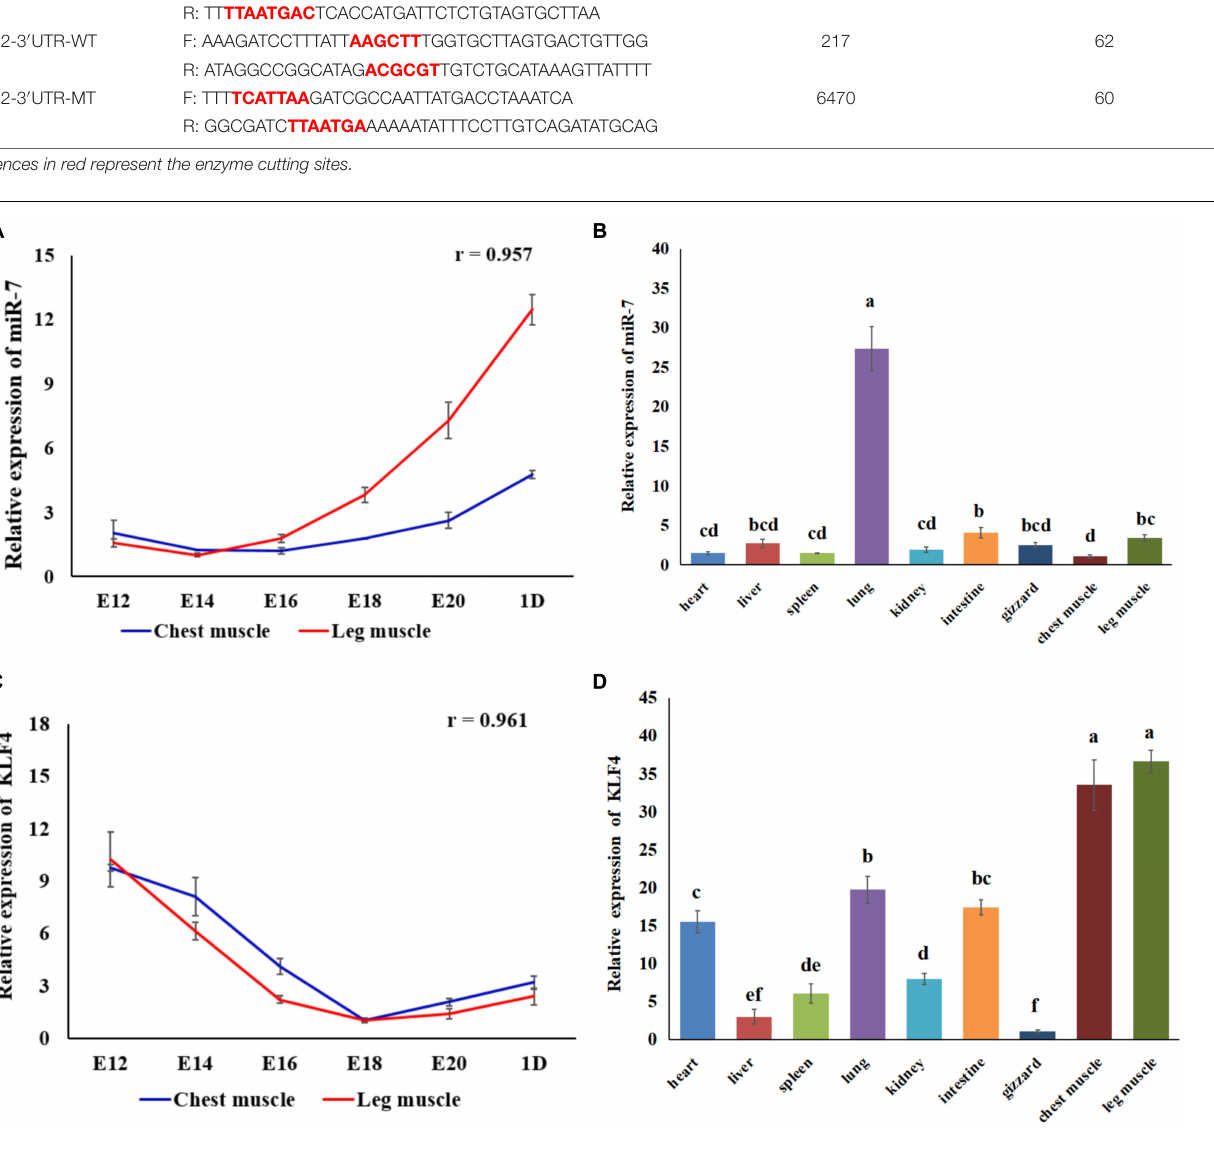
FIGURE 1 | Expression of miR-7 and KLF4 gene in the tissues of Jinghai Yellow chickens. (A) Expression pattern of miR-7 in chest and leg muscles. (B) Expression profile of miR-7 in the tissues of 1-day-old chickens. (C) Expression pattern of the KLF4 gene in chest and leg muscles. (D) Expression profile of the KLF4 gene in the tissues of 1-day old chickens. E12, E14, E16, E18, E20, and 1D represent 12, 14, 16, 18, 20 embryonic days and 1-day-old, respectively. Data are presented as mean ± standard error of the mean (SEM) ( N = 4). Different lowercase letters above bars indicate significant differences ( p <